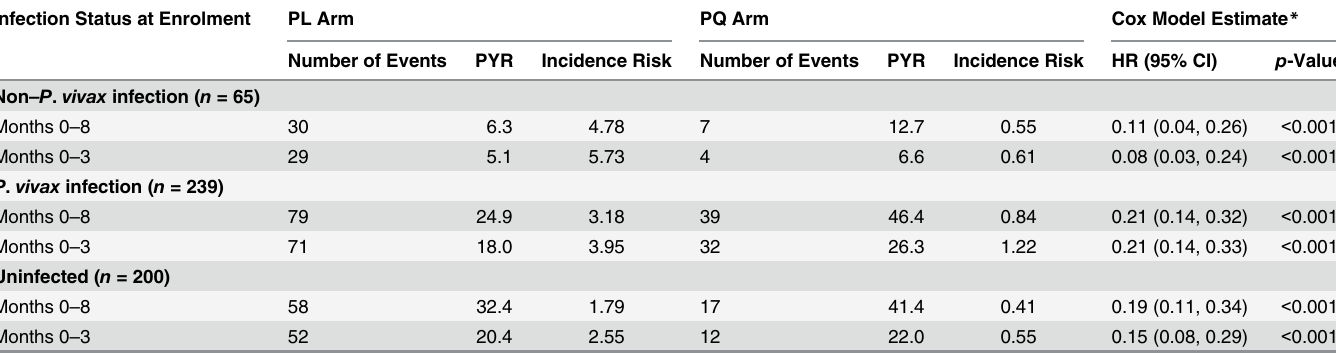
The initial reductions achieved by each of the interventions against P . falciparum and P . vivax are the same; however, when only blood-stage drugs are administered, a rapid rebound in P . vivax prevalence is predicted due to the hypnozoite reservoir, which is left unaffected by the treatment. Notably, P . vivax levels are predicted to return to pre-intervention levels within 6 mo post-intervention for both the MDA and MSAT interventions (blue curves in Fig 6A and Table 5. P . vivax re-infection by qPCR in treatment groups during the entire 8 mo follow-up period and during the first 3 mo of follow-up, stratified by P . vivax infection status at enrolment. Infection Status at Enrolment PL Arm PQ Arm Cox Model Estimate * Number of Events PYR Incidence Risk Number of Events